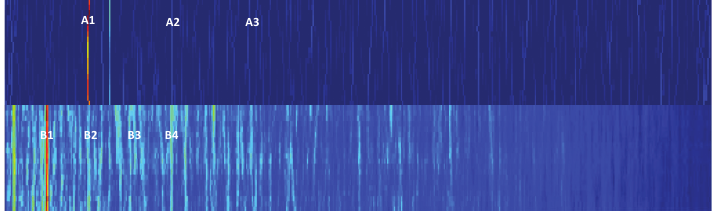
Figure 3. An example of the LOFAR and DEMON spectrums in high-speed rotation (“Hailangdao” ship, 1200 r min − 1 ), with upper for LOFAR and lower for DEMON. Letter and digital annotations · are used to illustrate the harmonic relationship between spectral lines. The vertical axis represents time and the horizontal axis